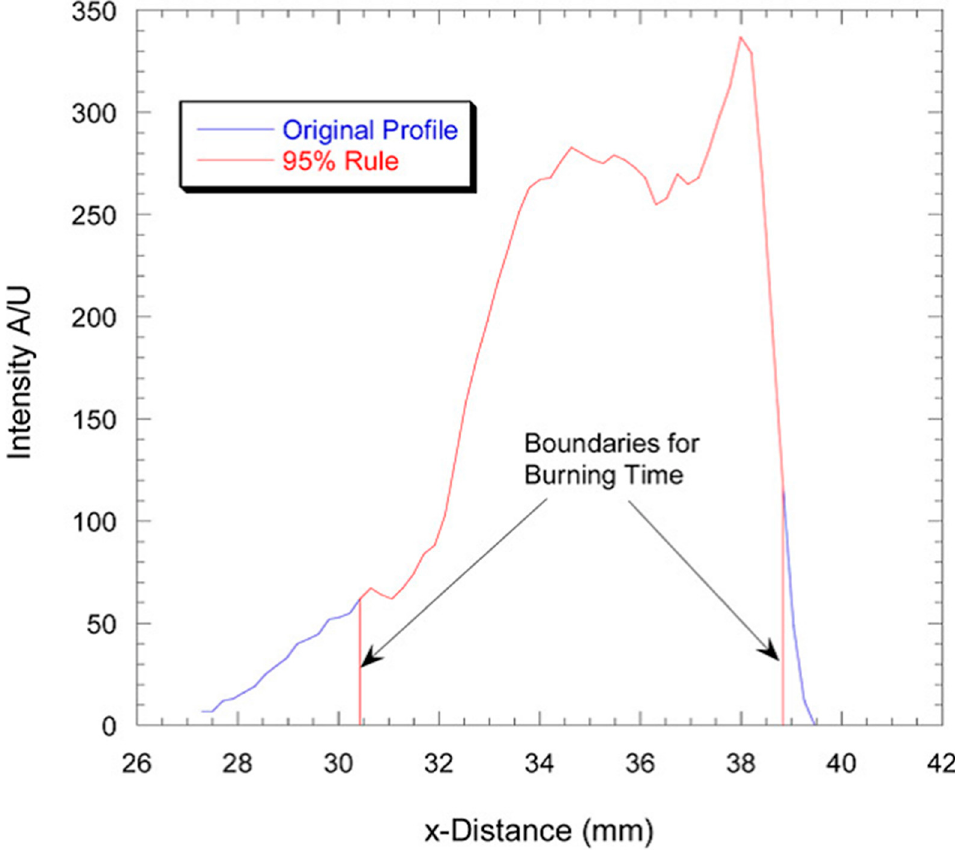
Figure 16. Illustration of t 2 burning time determination (X O2 = 0.2, T = 1808 K). Reproduced from [9], with permission from Elsevier, 2009.